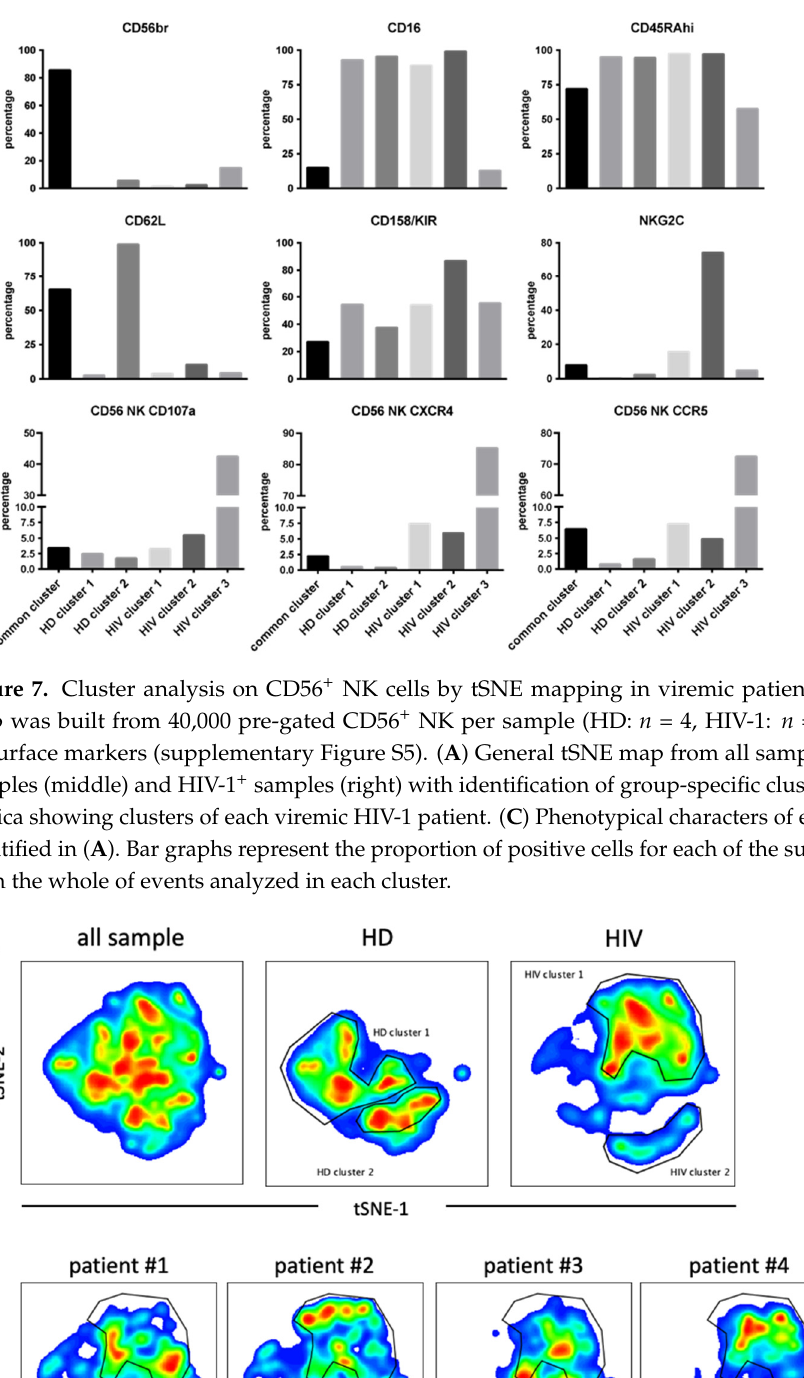
Figure 8. Cluster analysis on CD56negCD16 + NK cells by tSNE mapping in viremic patients. tSNE map was built from 2500 pre-gated CD56 neg CD16 + NK per sample (HD: n = 4, HIV-1: n = 4) based on 12 surface markers (supplementary Figure S6). ( A ) General tSNE map from all samples ( left ), HD samples ( middle ) and HIV-1 + samples ( right ) with identification of group-specific clusters. ( B ) tSNE replica showing clusters of each HIV-1 + patients. ( C ) Phenotypical characters of each cluster as iden- tified in ( A ). Bar graphs represent the proportion of positive cells for each of the surface markers from the whole of events analyzed in each cluster.